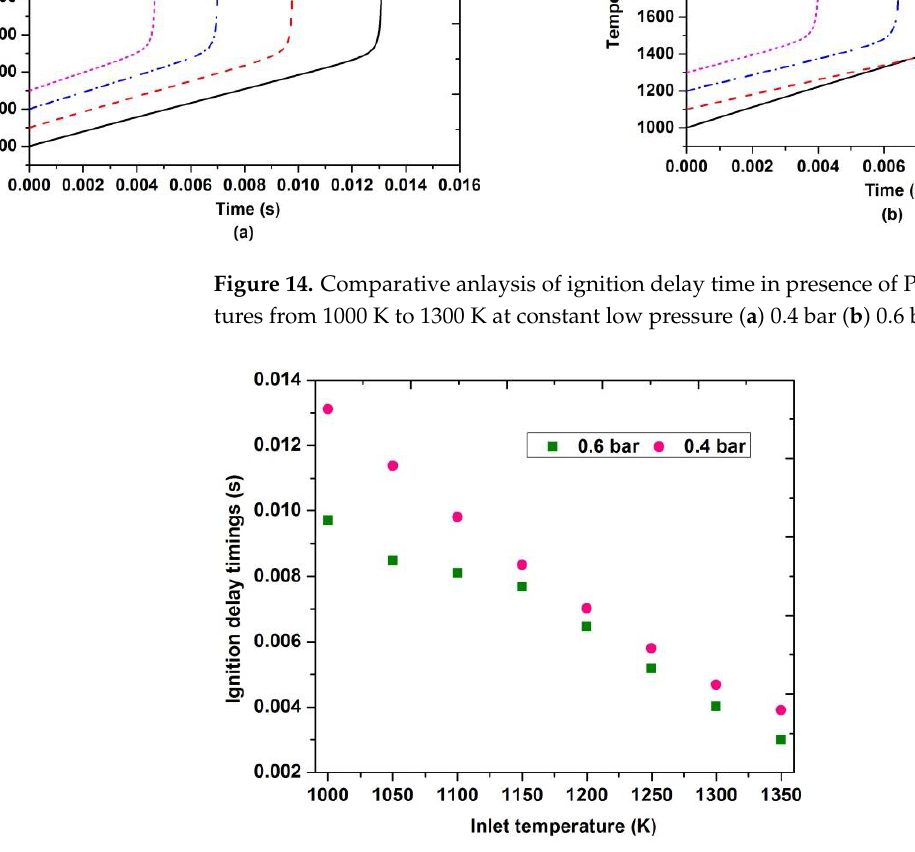
Figure 15. Parametric study of ignition delay time at low inlet temperatures at fixed inlet pressure 0.4 and 0.6 bar in presence of PAI.